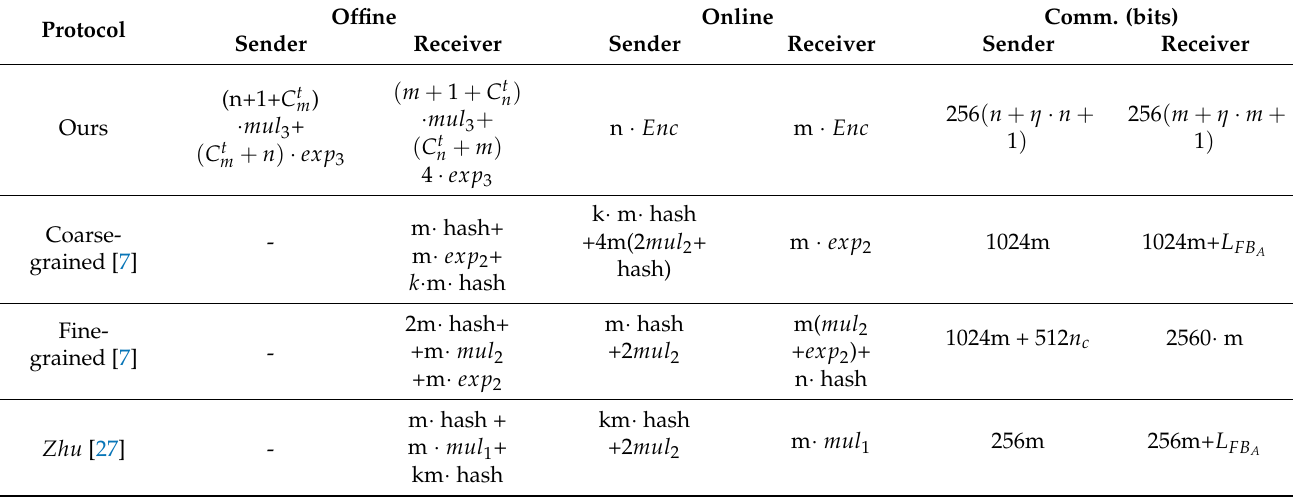
Table 1. Comparison of matching schemes.